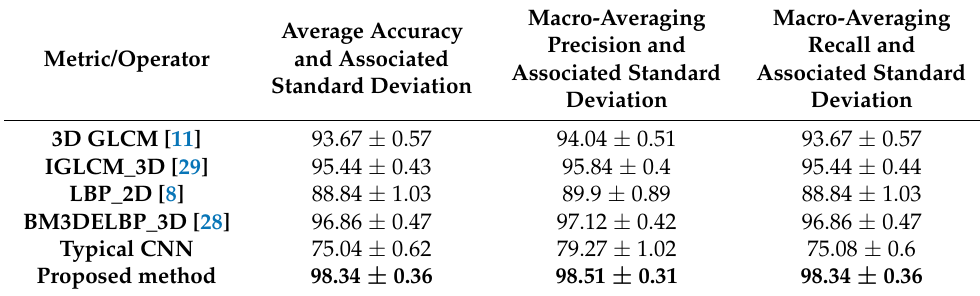
Figure 15. ( a ) smoothed misclassified sample from class PerlinNoise ( b ) smoothed training image from class PerlinNoise ( c ) smoothed training image from class Uwari. Table 7. Classification results for the second experiment with the SVM classifier [%].